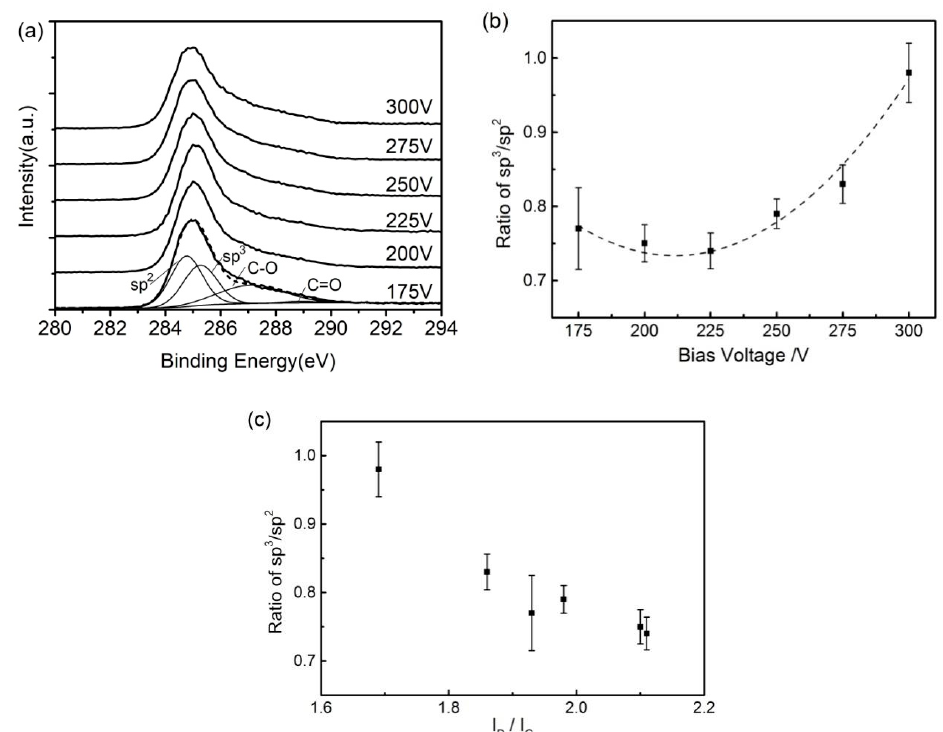
Figure 3. ( a ) X-ray photoelectron spectroscopy (XPS) spectra of DLC films with various ratios of sp 3 / sp 2 . ( b ) Ratio of sp 3 / sp 2 as a function of bias voltages. ( c ) Ratio of sp 3 / sp 2 with I D / I G.